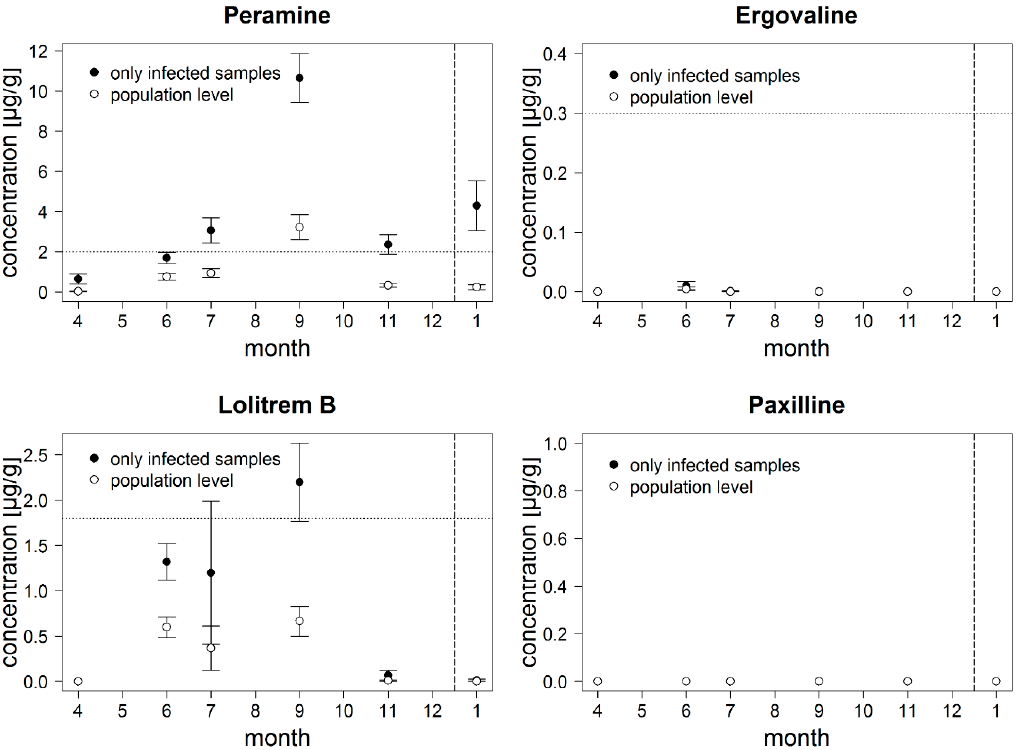
Figure 1. Concentrations of peramine and lolitrem B in one year in 2018 and the beginning of 2019 on five study sites in Schorfheide-Chorin, Germany, on population level (unfilled dots: µ g / g dry weight (DW), mean ± SE, n = 575). Ergovaline and paxilline were not detected in the samples. Filled dots show only infected samples (mean ± SE, n = 133). Dotted horizontal line indicates toxicity threshold of the alkaloid based on dry weight and dashed vertical line indicates the turn of the